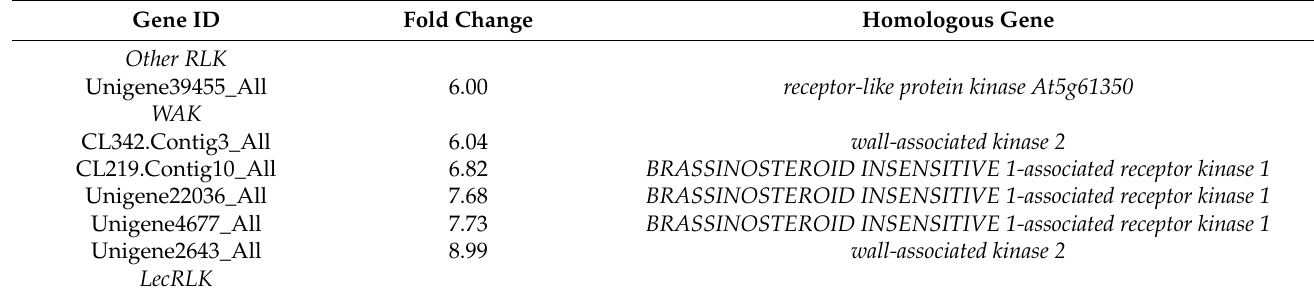
Figure 7. Number of DEGs related to protein kinases under 100 mM NaCl treatment for 6 and 24 h in leaves ( A , B , respectively) and in roots ( C , D , respectively) of A. canescens . CTR1: high-affinity K + transporter, MAPK: mitogen-activated protein kinase, CDPK: calcium-dependent protein kinase, LysM: lysine motif, LRR-RLK: leucine-rich repeat receptor-like kinase, LecRLK: lectin-domain-containing receptor kinase, WAK: cell-wall associated kinases, RLK: receptor-like protein kinase. The red upward arrows and black downward arrows indicate the total number of upregulated DEGs and downregulated DEGs, respectively. Table 15. The upregulated DEGs related to protein kinases in the roots of A. canescens under 100 mM NaCl, but not under control conditions, for 6